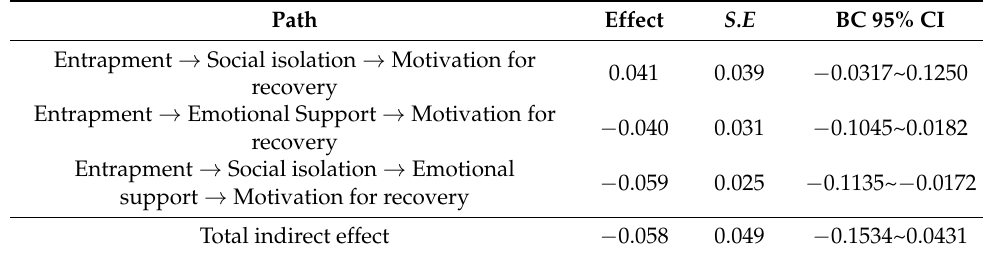
Table 4. Indirect effects of the mediation model. Path Effect S.E BC 95% CI Entrapment → Social isolation → Motivation for 0.041 recovery